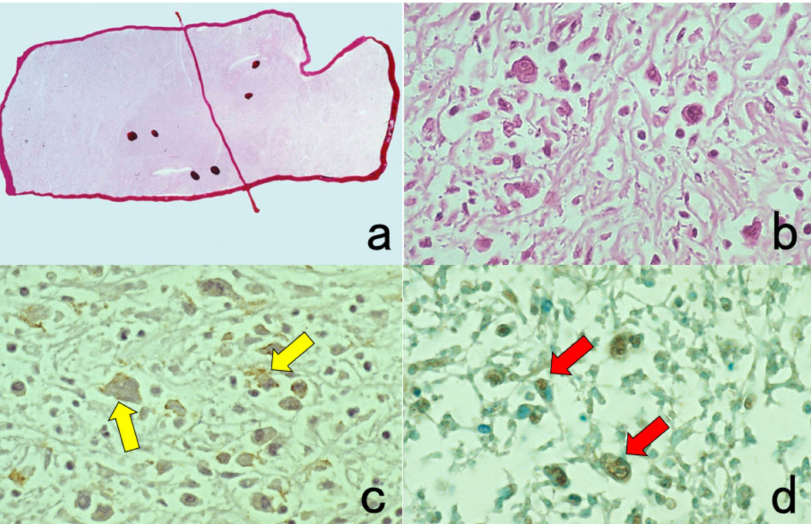
Figure 8. Demonstration of CD15 and EBER in Hodgkin’s lymphoma in a male patient in his 50s autopsied by Dr. Thomas Hodgkin himself 170 years ago. Top panels: H&E. Only one unstained slide of the liver available was stained with H&E. After photographing, the section was transferred to two silane-coated glass slides ( a ). Infiltration of Reed-Sternberg cells or Hodgkin’s cells is micro- scopically recognized ( b ). Bottom panels: Immunostaining for CD15 ( c ) and in situ hybridization for EBER ( d ) gave positive signals on the plasma membrane and in the nucleus, respectively, as indicated by yellow and red arrows.